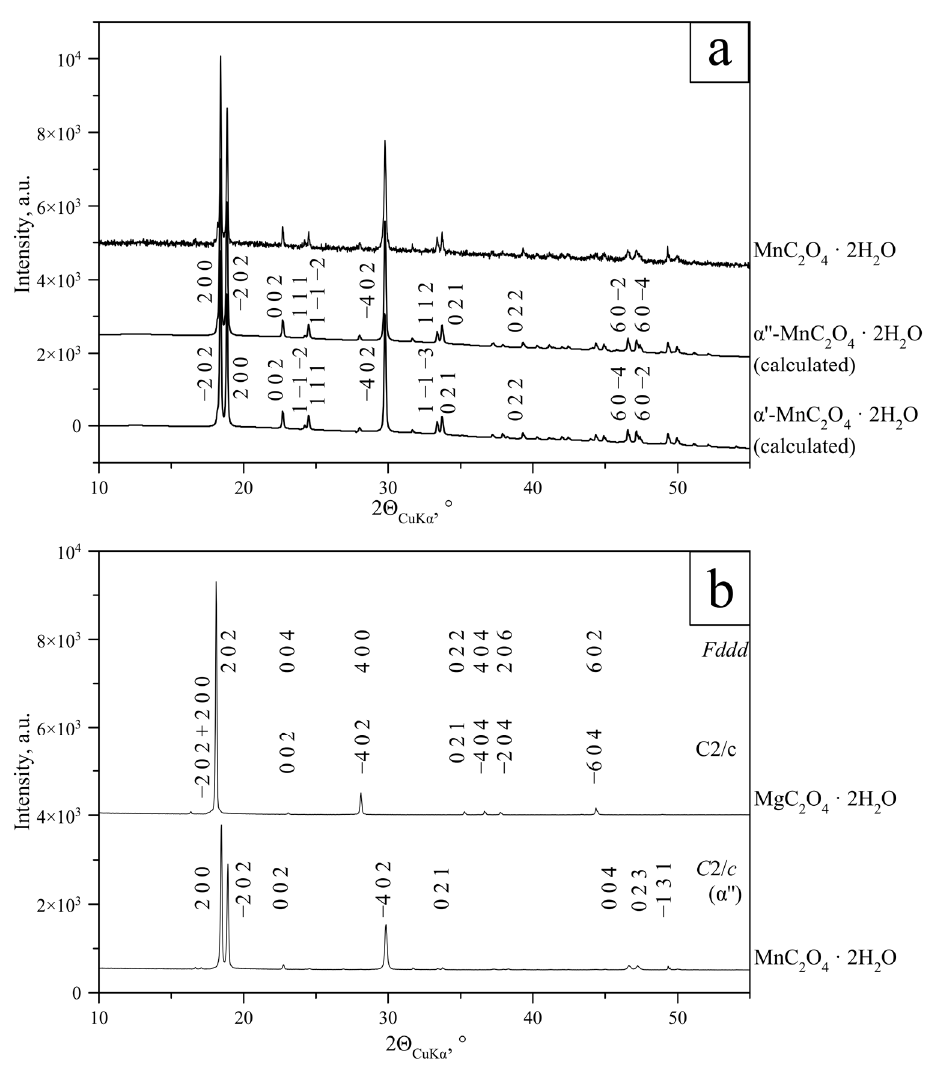
Figure 2. Results of indexing of end-members: ( a )—MnC 2 O 4 ∙ 2H 2 O for α ’ - and α ’’ -modifications (sp. gr. C 2/ c ); ( b )—MgC 2 O 4 ∙ 2H 2 O for α - and β -modifications (sp.gr. C 2/ c and Fddd , respectively). MnC 2 O 4 ∙ 2H 2 O pattern indexed in C 2/ c space group ( α ’’-modification) is given for comparison.